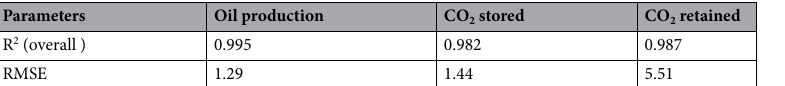
all training, validation, and testing demonstrates the cumulative CO 2 retained networks.